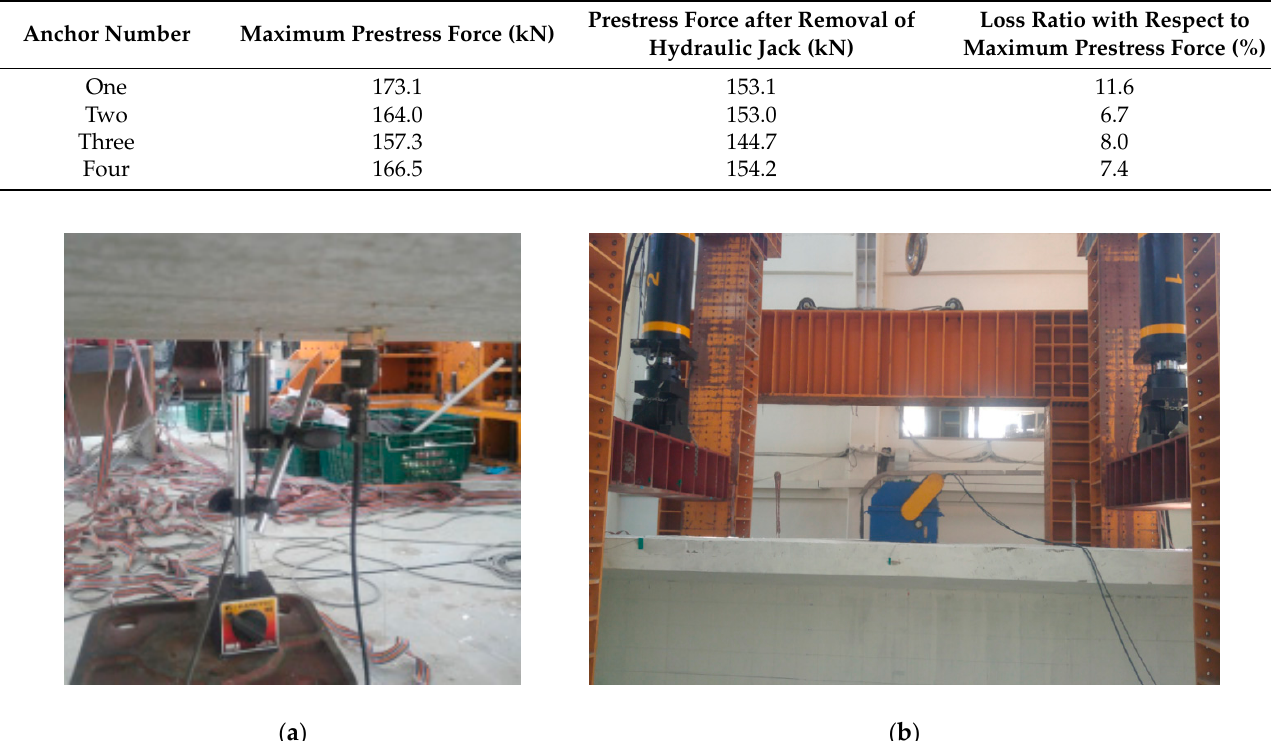
Figure 10. Loading test of full-scale BH girder bridge prototype: ( a ) Installed accelerometer; ( b ) Actuators.